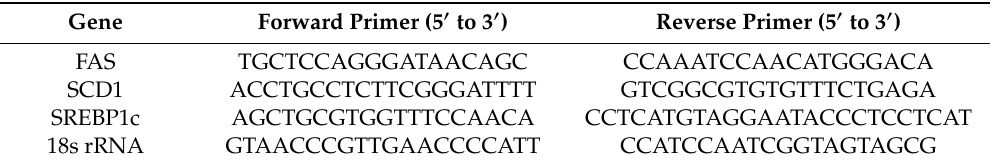
Table 3. qRT-PCR mouse primer